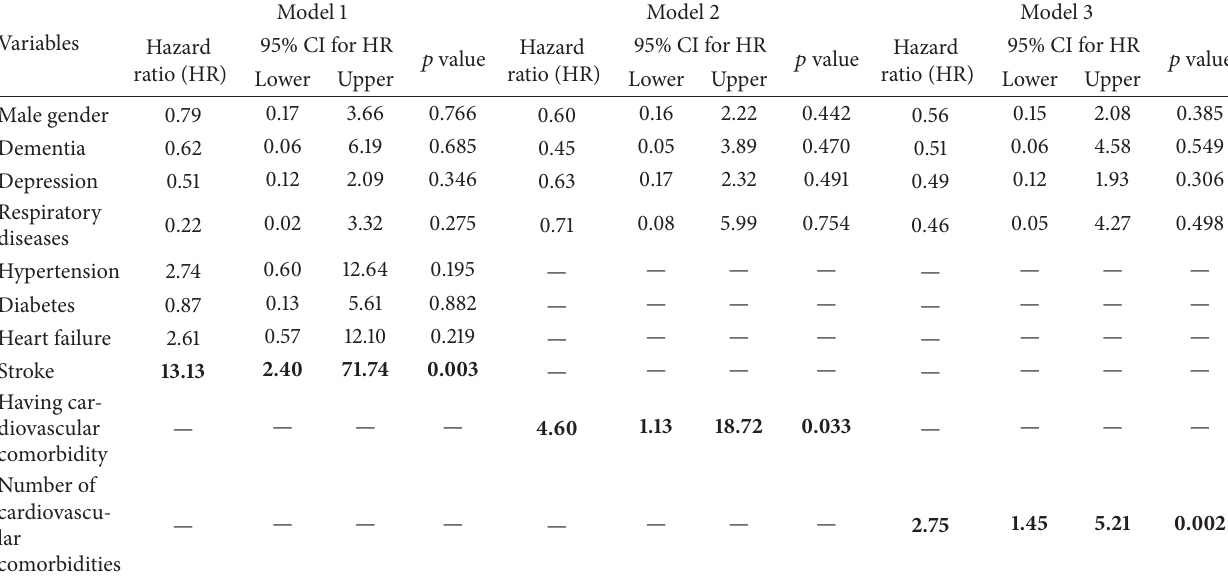
Table 2: Cox regression models to find independent factors predicting mortality in recruited Parkinson’s disease patients.